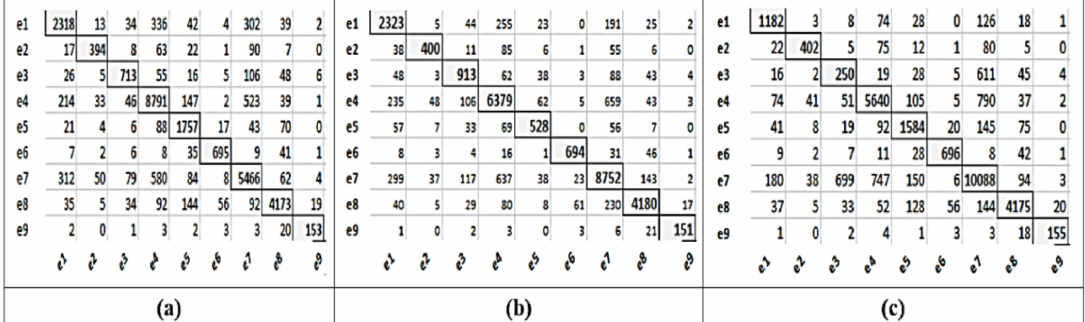
Figure 6. Best-case confusion matrices obtained for inferring emotion tags based on top-level object categories using K-NN classifier with ( a ) male responses, ( b ) female responses, ( c ) combined responses. The columns represent the predicted values, while the rows represent the ground truths. Here, e1, e2, e3, ... , e9 represent Amusement, Anger, Awe, Boredom, Contentment, Disgust, Excitement, Fear, and Sad emotion,